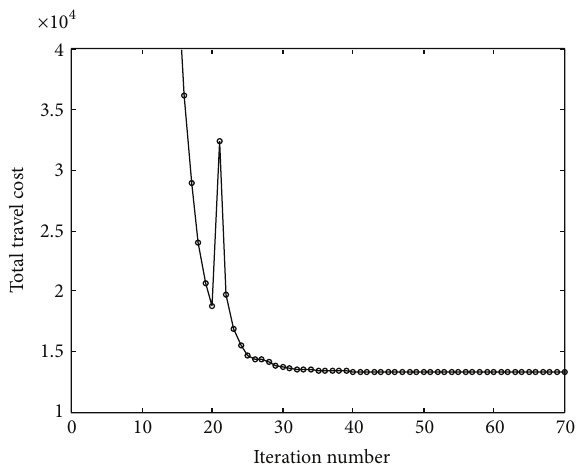
Figure 4: The objective function values versus the iterations of the GP